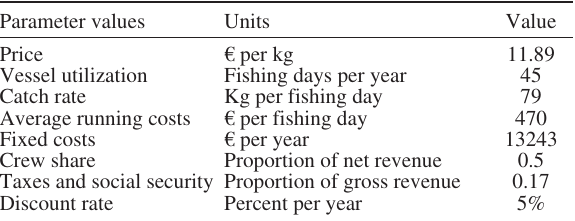
Table 3. – Data used for net present value analysis for the fishery of Plesionika edwardsii . Source: base values from Leocádio et al. (2012), updated by applying harmonised consumer price indexes from www.pordata.pt for diesel prices and Eurostat HCPI for all other